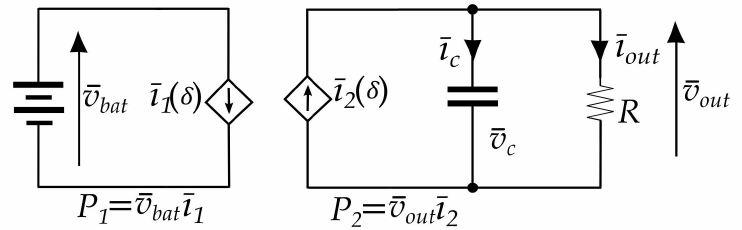
Figure 4. SPS-DAB model developed by averaging the converter output current.